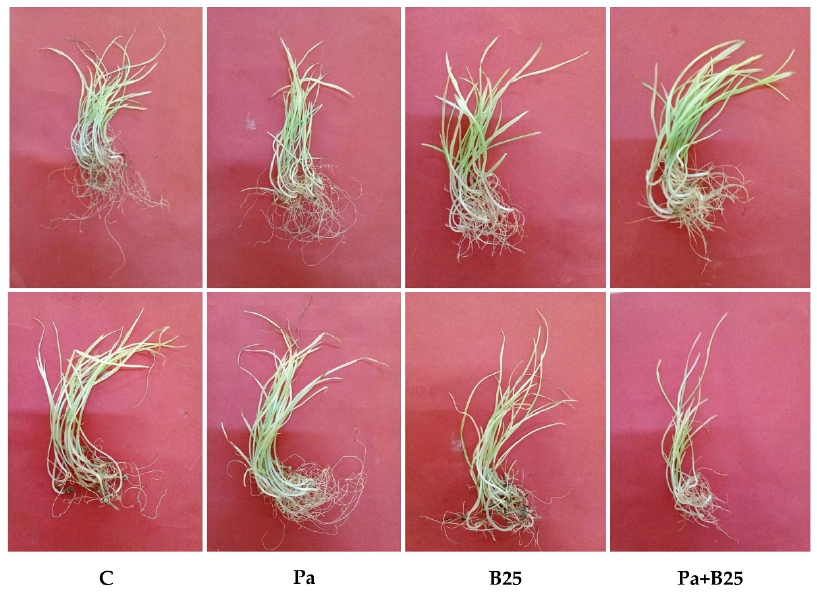
Figure 2. Effect of bacterial inoculation on in vitro wheat seedling germination. Top: Bousselam variety. Bottom: Boutaleb variety.